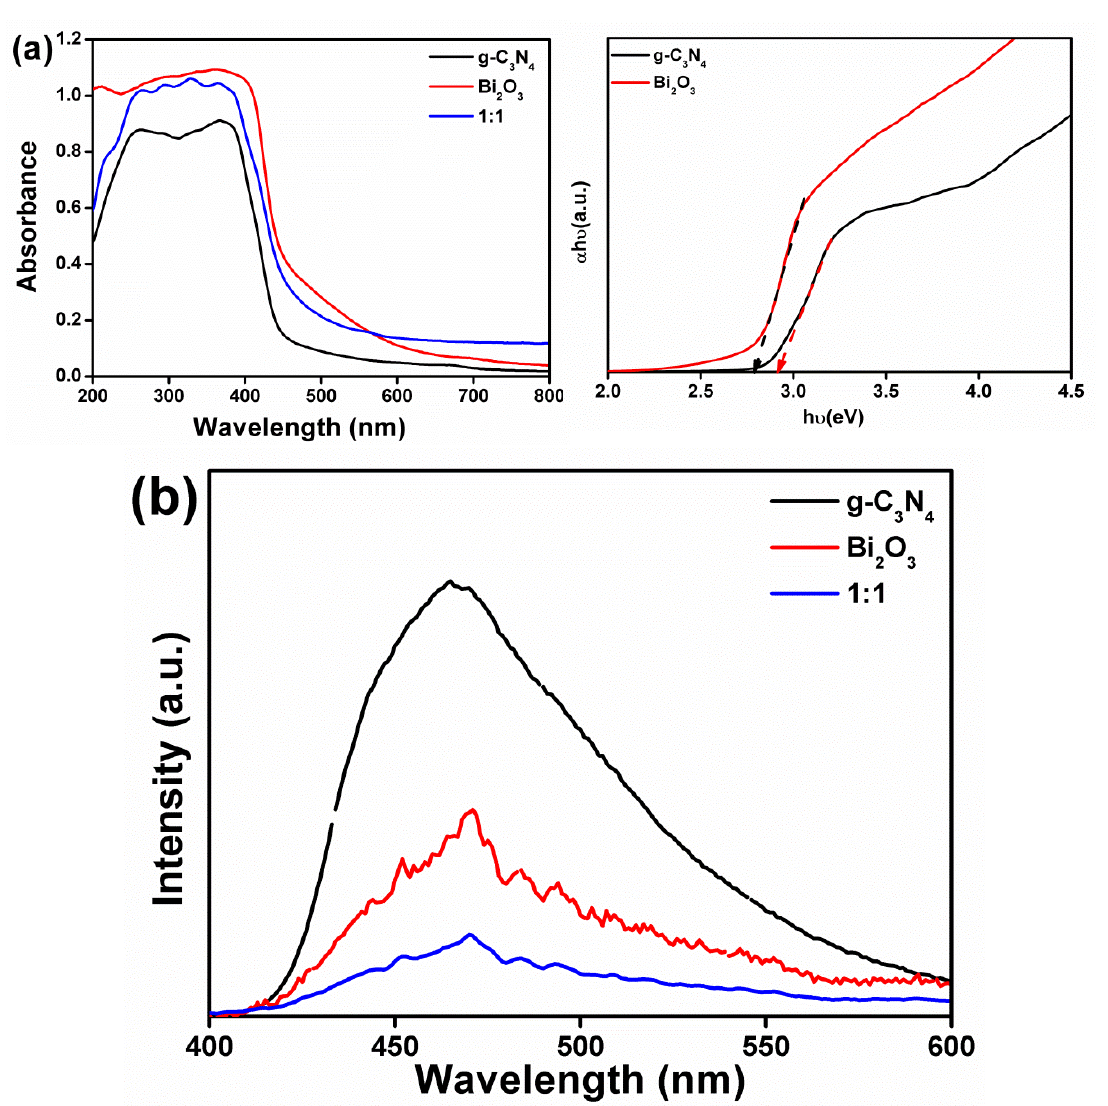
Figure 5. ( a ) UV-Vis-DRS spectra and ( b ) PL emission spectra.